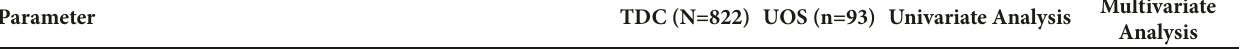
Table 3: Comparison (univariate and multivariate analysis) of baseline demographic and operative characteristicsof “true day cases” (TCD) and patients who required an unexpected overnight stay